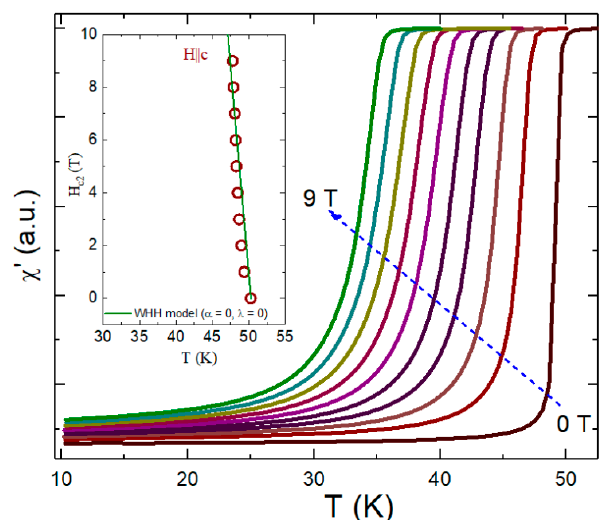
Figure 4. The temperature dependence of the complex ac-susceptibility components of NdFeAsO 0.8 F 0.2 . The inset illustrates the phase diagram of H c 2 vs. temperature. The solid lines are fits to the Werthamer–Helfand–Hohenberg (WHH) model for λ = 0 with α = 0.